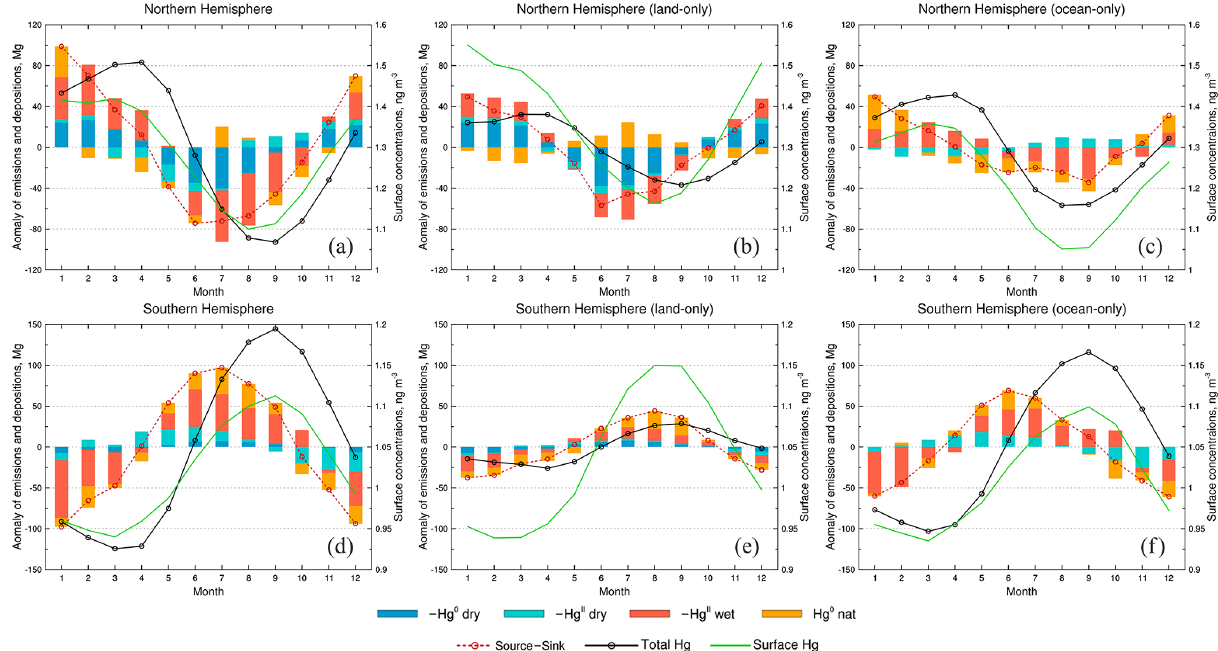
Figure 10. Seasonal variations of atmospheric Hg in (a) Northern Hemisphere, (b) Northern Hemisphere land areas only, (c) Northern Hemisphere ocean areas only, (d) Southern Hemisphere, (e) Southern Hemisphere land areas only, and (f) Southern Hemisphere ocean areas only. The bars represent the anomaly of different processes: deep blue for Hg 0 dry deposition, cyan for Hg II dry deposition, jacinth for Hg II wet deposition, and orange for Hg 0 natural/legacy emission. The first three are reversed for their signs as they are sinks of Hg. The anomaly of the difference between the source and the sink is shown as the red dashed line with circles, and the solid black line with circles is the anomaly of the total mass of atmospheric Hg. The solid green line represents the surface Hg